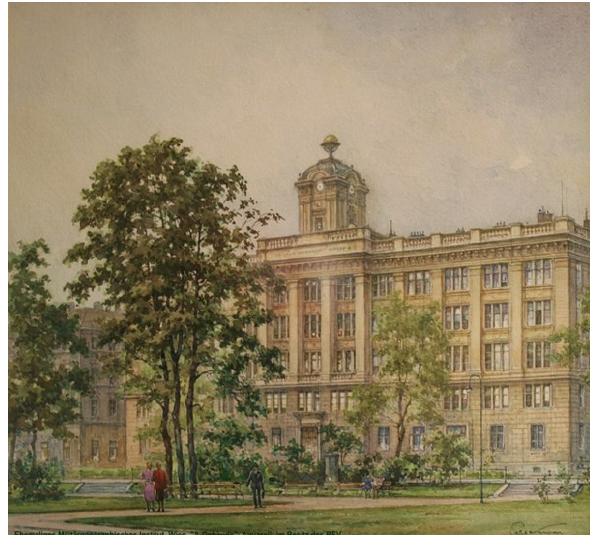
Figure 8. The Military Geographical Institute served as central office for the cadastral survey from 1843 until 1983, when the Federal Office (since 1921) moved to a bigger building. The cubic structure consists of a two-storey base zone, similar to the three upper floors, which are divided by giant Doric pilasters. In the centerline a tower-like pavilion was set up, which served as an observatory until 1927. (Painting after 1871, Source